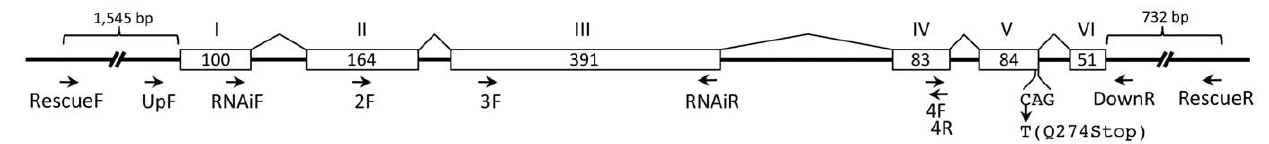
Figure 2. The gene structure of W06D4.2. Boxes represent individual exons (I-VI). The hc197 mutation (C 2. T) converts a glutamine residue to a premature stop. Horizontal arrows refer to oligonucleotide sequences. RescueF and RescueR were used to amplify the rescuing 3,626 bp fragment. RNAiF and RNAiR provided the RT-PCR amplicon (585 bp) that was used to construct an RNAi feeding clone. The UpF and DownR primers were used to amplify the cDNA sequence, which was confirmed by conventional DNA sequencing employing the remaining primers.